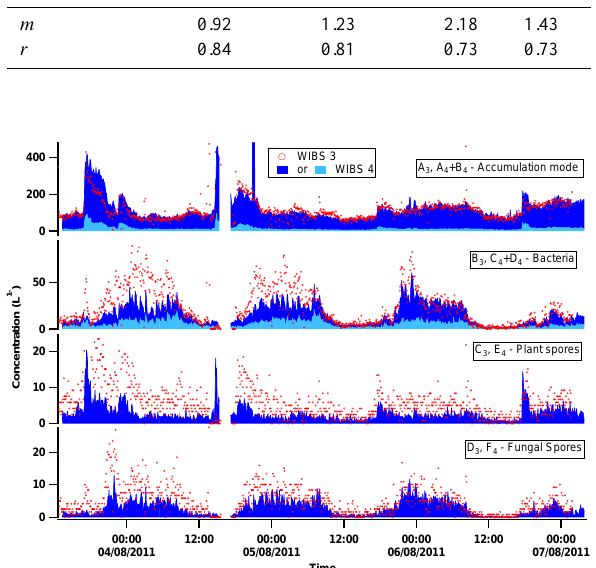
Fig. 8. Comparison of cluster time series over an exemplary period. WIBS3 time series shown by red points and WIBS4 time series shown by blue bars. Cluster names and their physical interpretation detailed in labels. A 4 (dark blue) and B 4 (light blue) are stacked from comparison to A 3 , and C 4 (dark blue) and D 4 (light blue) are stacked for comparison to B 3 . WIBS4 mea- surements from all profile heights are displayed. Rainfall (mean as a function of height) at the profile tower site is displayed at the bottom (log scale).